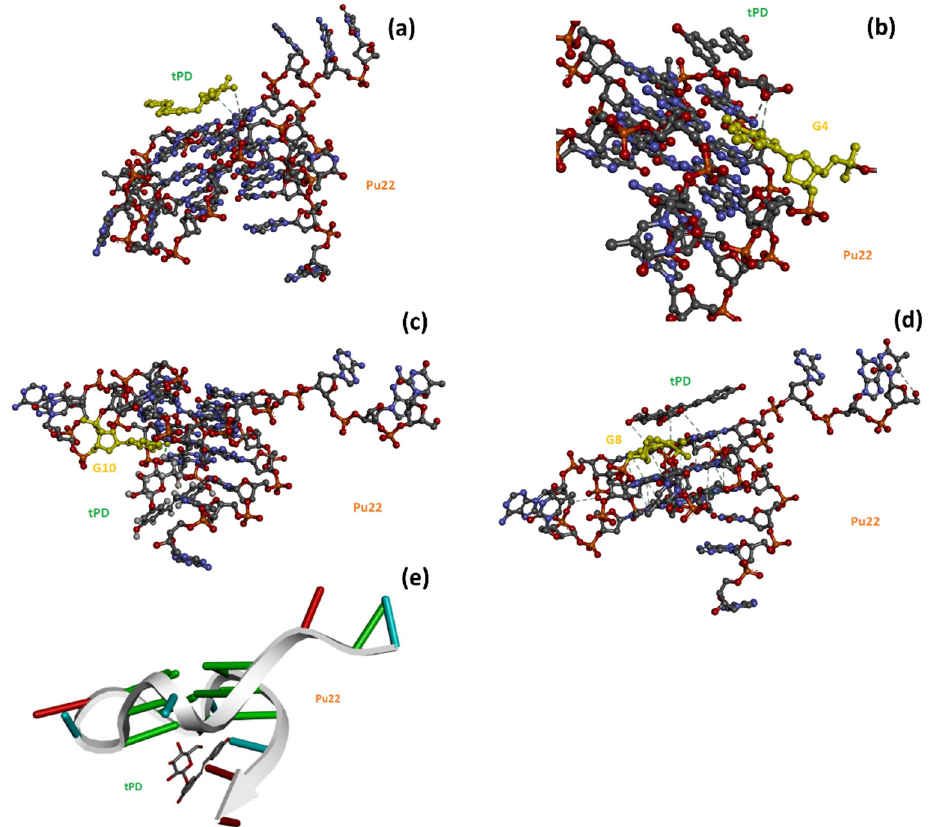
Figure 3. The docked structures of the tPD-Pu22, with the Pu22 PDB ID: 6AU4, corresponding to the top-1–3 ranked poses: ( a , b ) pose 1; ( c ) pose 2; ( d ) pose 3. Note how in poses 1 and 3, tPD seems to interact by end-stacking and H-bondings with the nucleotides represented in yellow in panels ( b , d ). Panel ( e ) reports a different depiction of pose 2 in which the backbone of Pu22 is represented as a white arrow and the base pairs as ladders for clarity.